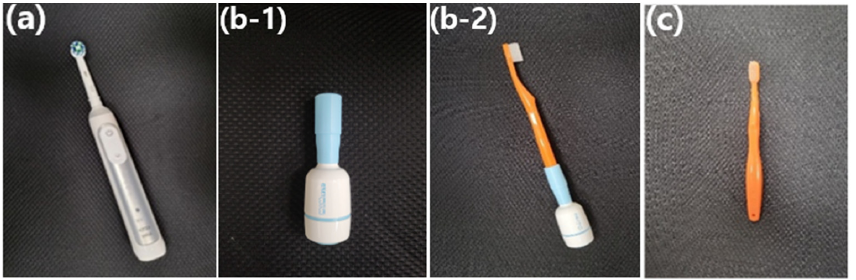
Figure 2. The toothbrushes used in this research. ( a ) electro-toothbrush (Oral-B, Procter and Gamble, Kronberg, Germany); ( b-1 ) smart toothbrush machine (ZiuSolution, Gyeonggi, Republic of Korea); ( b-2 ) machine linked to a manual toothbrush, referred to as a smart toothbrush; and ( c ) manual toothbrush (AIOBIO, Seoul, Republic of Korea). ST has a motion-sensing skill with a 3D accelerometer and magnetic sensor that per- ceives the location and movement of the toothbrush [14–16]. The location and movement data of the ST were converted and analyzed to evaluate the brushing habits and scores via a mobile application (Figure 3).